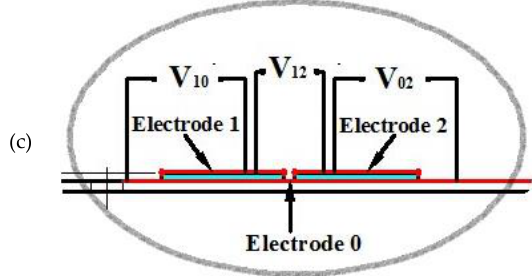
Figure 3. Double discrete electrodes and voltage outputs, ( a ) places of PZT and electrodes; ( b )connections of electrodes for output voltages; ( c ) enlargement of the area A in ( b ). In this case, the converting factor should be expressed as: